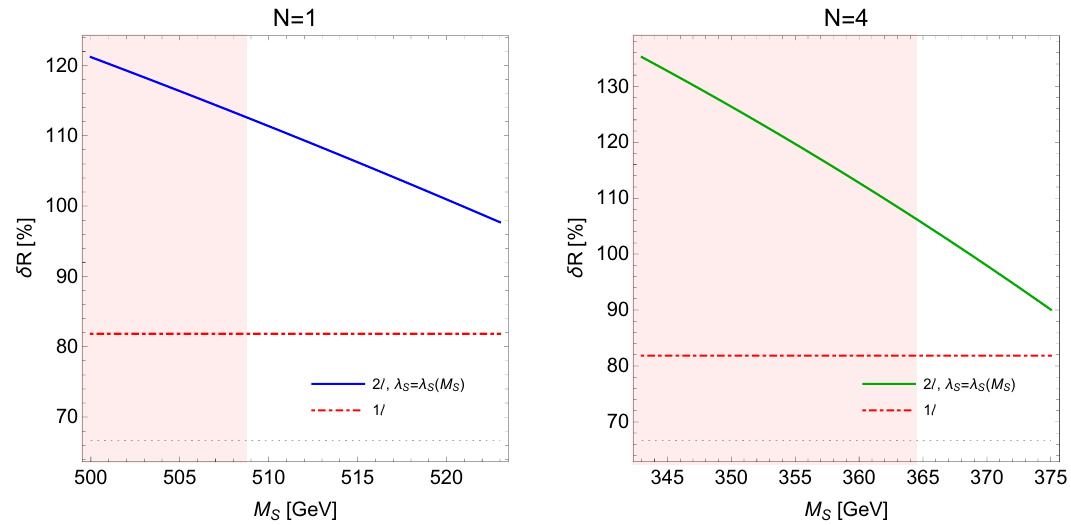
Figure 6 . BSM deviation δR — defined in eq. (3.12) — of the Higgs trilinear coupling ˆ λ hhh computed at two loops in the O ( N ) -symmetric CSI model with respect to its usual (i.e. non-CSI) SM prediction. The blue curve (left side) is the two-loop result obtained for N = 1 , while the green curve (right side) is the two-loop result for N = 4 . Moreover, for this figure, λ S is calculated as a function of M S (for N = 1 on the left side and N = 4 on the right side) using equation (3.11). The red dot-dashed line shows the one-loop result for δR , while the black dotted line is the comparison of the one-loop CSI result with the tree-level SM one. Finally, the light-red shaded regions are excluded by tree-level perturbative